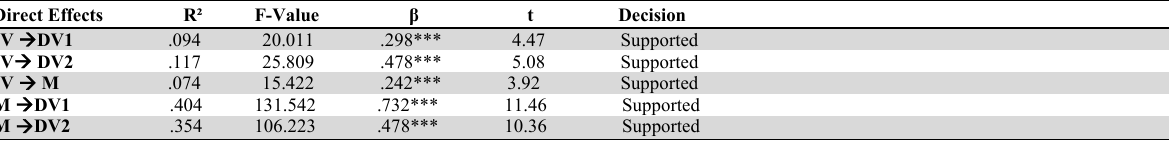
The results of direct effects